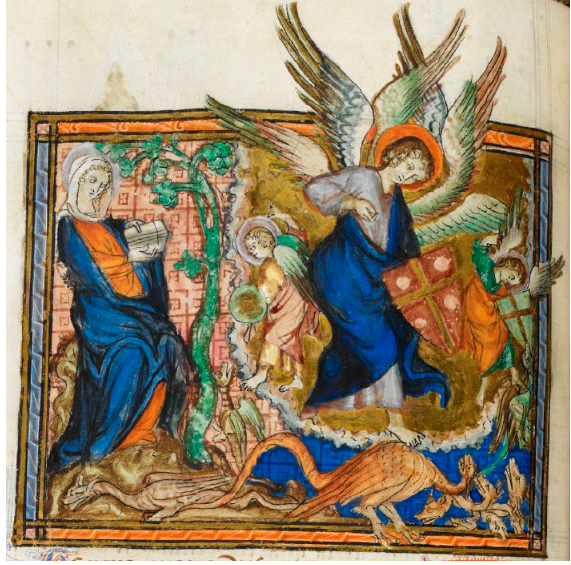
Figure 10. Abingdon Apocalypse (© British Library Board MS Add. 42555). Fol. 66v, c. 1270–75.